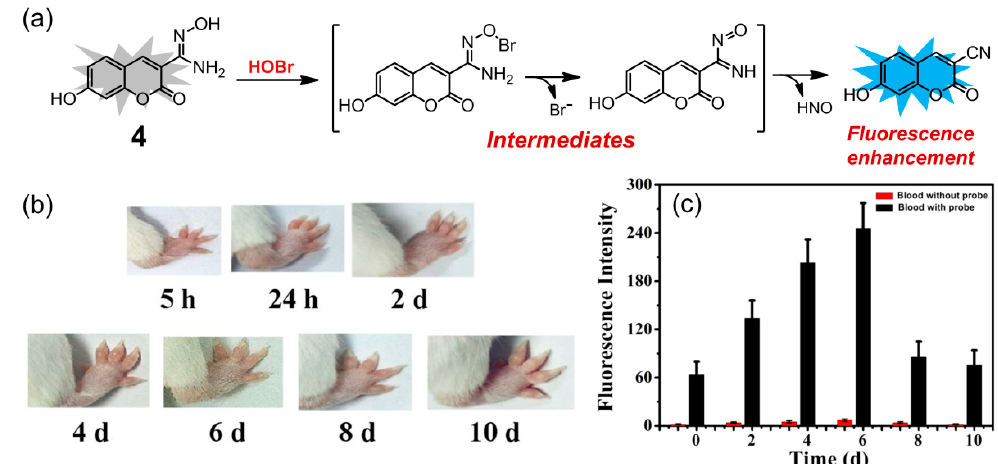
Figure 5. ( a ) Coumarin-based fluorescent probe 4 for HOBr; ( b ) swelling changes of right foot of mice within 10 days after injection of Freund’s adjuvant; ( c ) fluorescence response of probe 4 (50 μ M) added in the blood of arthritis model mice within 10 days ( λ ex = 395 nm, slits: 5/5 nm). Reproduced with permission from Reference [75]. Copyright 2020 Elsevier.